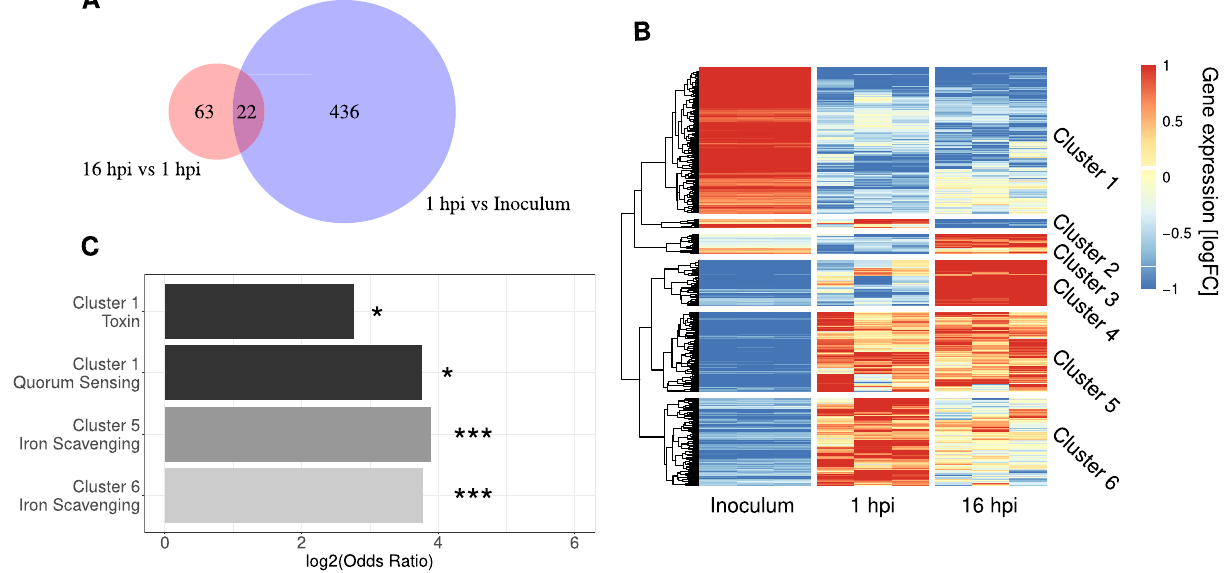
Figure 4. Analysis of differentially expressed genes for S. aureus between the inoculum, 1 hpi, and 16 hpi after logFC shrinkage. ( A ) Venn diagram visualizing the differentially expressed genes in the two comparisons with overlap showing the commonly regulated genes. ( B ) Heat map displaying the overall expression profile of all 521 differentially expressed genes grouped into 6 clusters indicating either up- or downregulation at specific time points during infection. Gene expression values were log2 transformed and hierarchically clustered according to Euclidean distances with the complete linkage approach. ( C ) Virulence ontology enrichment analysis of